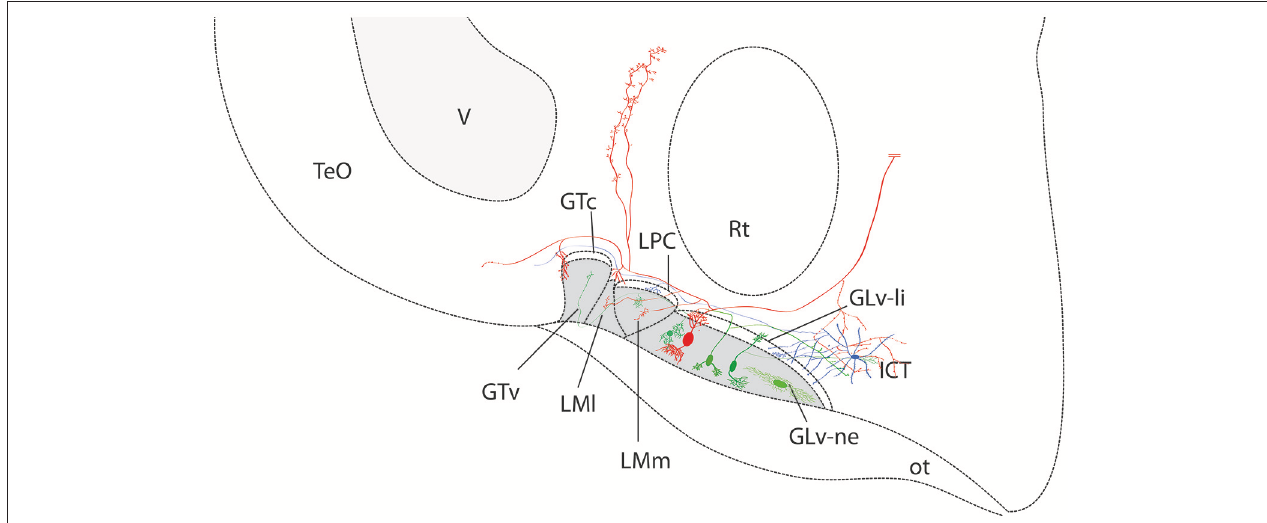
FIGURE 11 | Summary diagram of the ventrothalamic neural circuitry. The parallel lines (in red) at the end of the axon shows that it continues beyond the confines of the slice. The retino-recipient region is represented with gray shading. Note that the GLv-li, LPC, and GTc are absent of retinal endings.